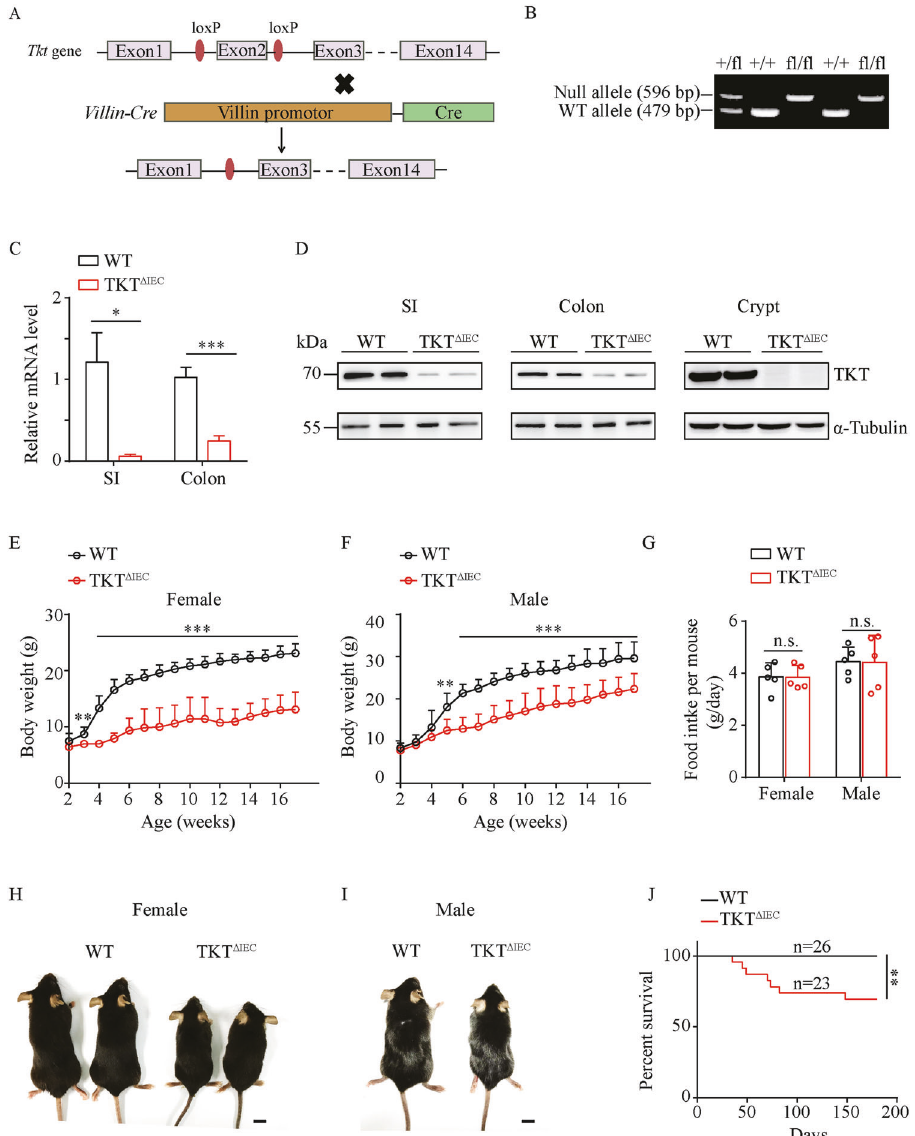
Fig. 1 TKT de fi ciency in intestinal epithelium results in growth retardation. A Schematic diagram of the strategy to generate TKT Δ IEC mice. B PCR analysis for TKT WT and null alleles. C QPCR analysis of TKT mRNA expression in small intestines and colons from WT and TKT Δ IEC mice ( n = 5). D Western blotting analysis of TKT protein levels in tissues from WT and TKT Δ IEC mice. E Body weight of female WT and TKT Δ IEC mice at different ages ( n = 9 for WT mice, n = 8 for TKT Δ IEC mice). F Body weight of male WT and TKT Δ IEC mice at different ages ( n = 8 for WT mice, n = 10 for TKT Δ IEC mice). G Food intake of WT and TKT Δ IEC mice ( n = 5). H Representative images of female WT and TKT Δ IEC mice at the age of 4 months. Scale bars, 1 cm. I Representative images of male WT and TKT Δ IEC mice at the age of 3 months. Scale bars, 1 cm. J Kaplan – Meier survival curve of WT and TKT Δ IEC mice (log-rank test). Data are represented as mean ± SEM. Signi fi cance is determined by Student ’ s t test analysis, * P < 0.05, ** P < 0.01, *** P <